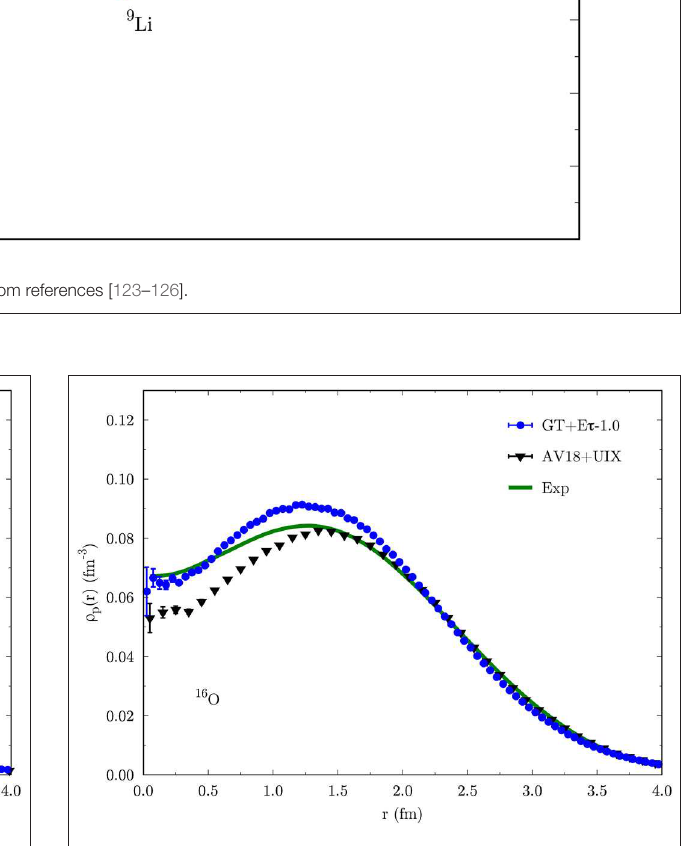
FIGURE 5 | Proton density in 12 C. Black triangles are GFMC results for the AV18+IL7 potential [130]. Blue dots are AFDMC results for the GT+E τ -1.0 interaction [89]. The green band corresponds to the experimental results, unfolded from electron scattering data (see text for details).